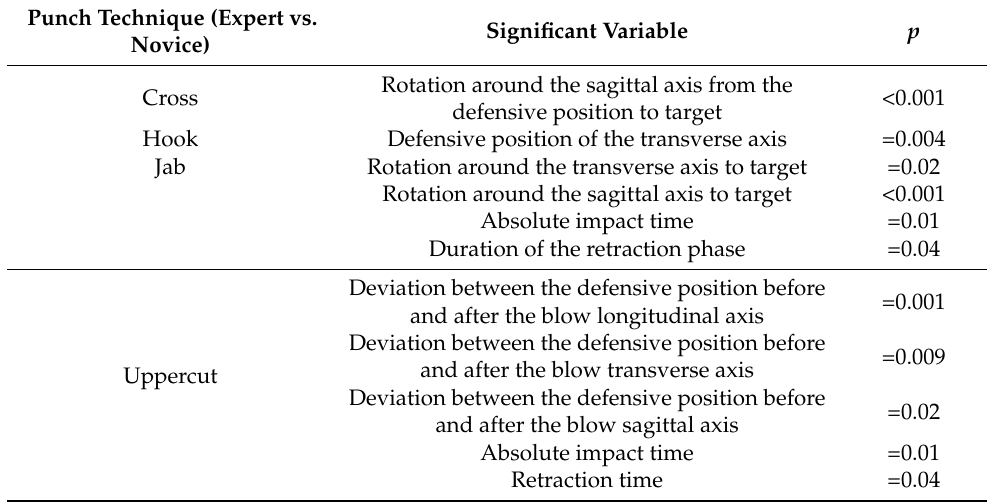
Table 7. Presentation of the significant punch type results. Punch Technique (Expert